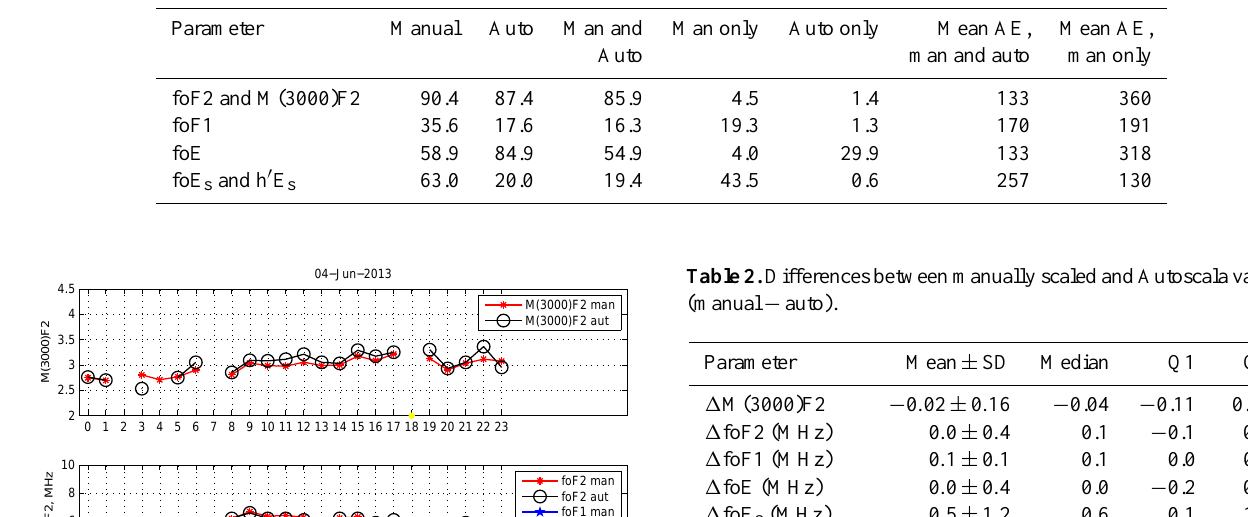
Table 1. Number of identifications of F- and E-layer parameters, % out of in total 2610 ionograms. Auroral activity is indicated by the mean AE index for the cases of both manual and automatic identification and only manual identification, respectively.